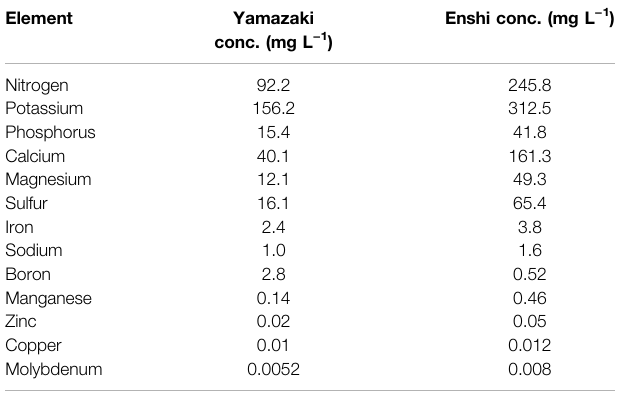
TABLE 3 | Concentration table of commonly used Yamazaki lettuce and Enshi strawberry nutrient solutions (Liu and Huang, 2019). Element